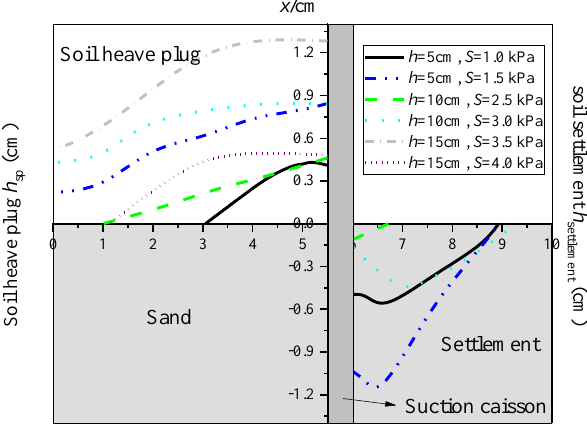
Figure 9. The height of soil plug and soil settlement outside the caisson.